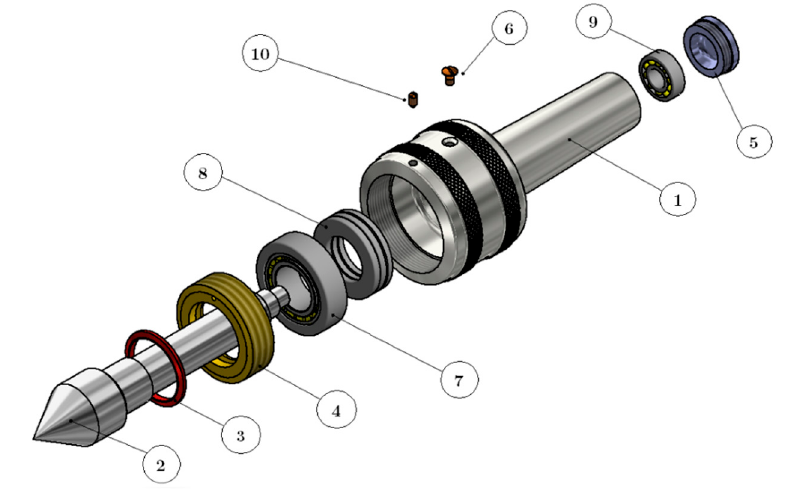
Figure 7. Exploded view.